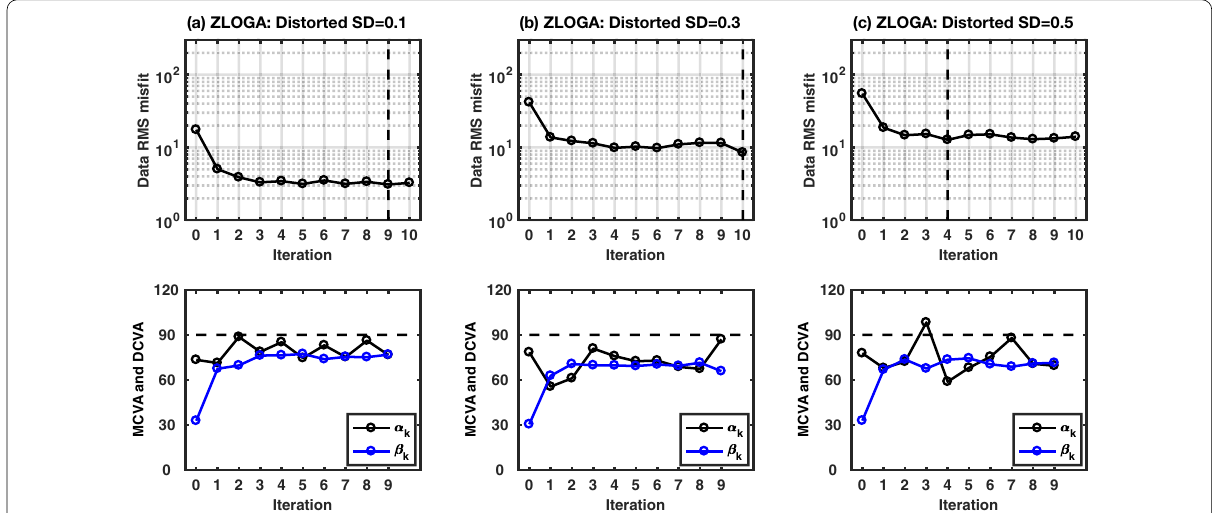
Fig. 19 dRMS (top, black solid curve with symbols) and the MCVA (bottom, black) and DCVA (bottom, blue) at each iteration step obtained from inverting ZLOGA distorted with SD values of a 0.1, b 0.3, and c 0.5 using SSQ1D as the initial model. Dashed lines in the dRMS plots indicate the iteration step, where the dRMS is minimized